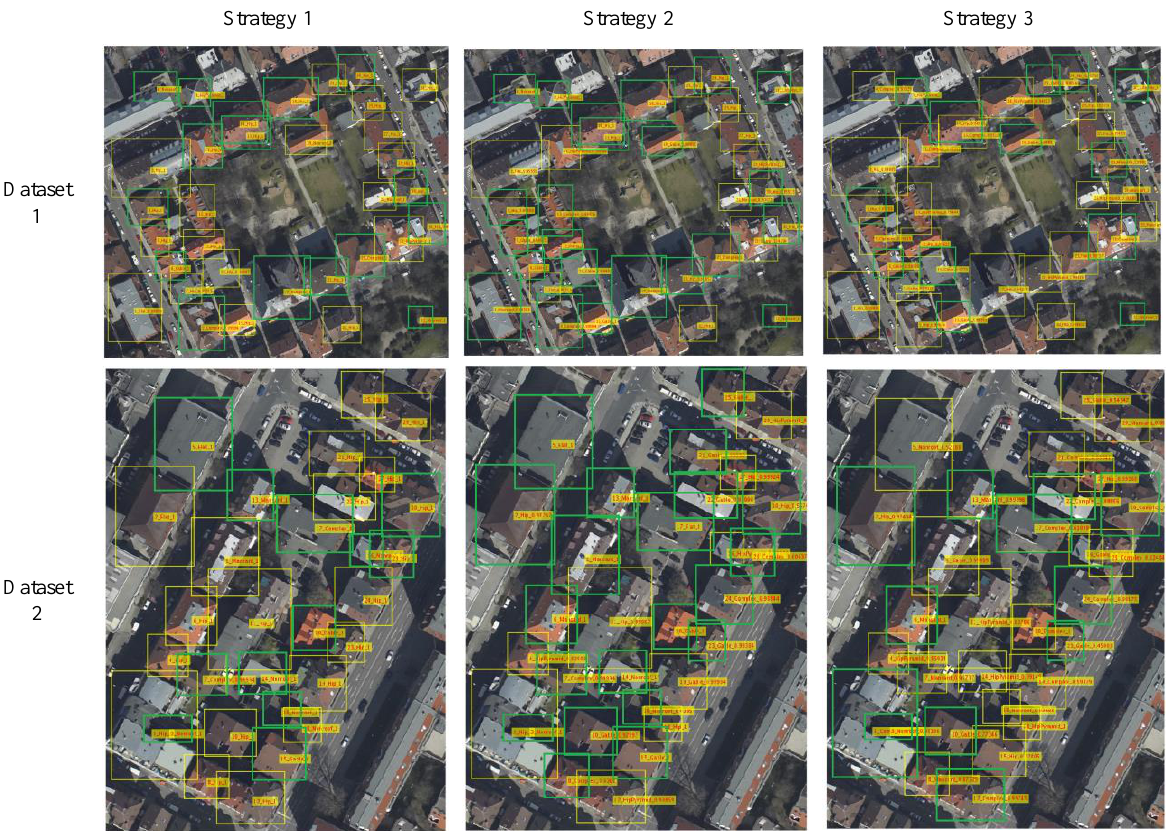
Figure 5. The Final results of buildings’ roofs detection and recognition based on three strategies for two